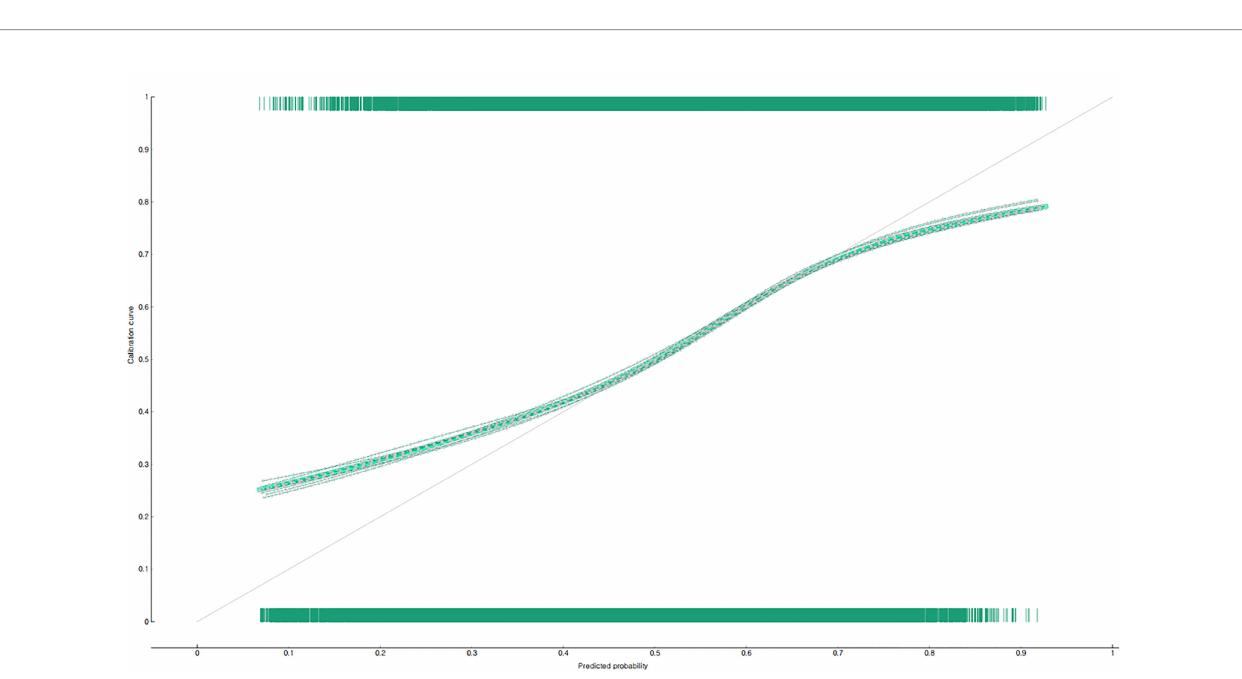
FIGURE 4 | Prediction performance of the nomogram for predicting the non-utilization of microprotein urination test in South Korean diabetic patients: calibration